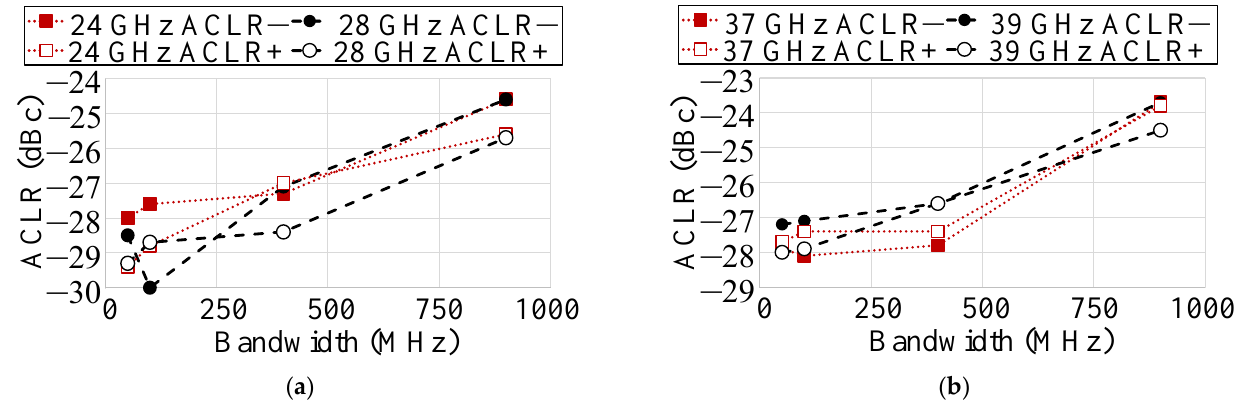
Figure 16. Measured ACLR+/ACLR- vs. carrier BW of the broadband CMOS FD-SOI PA at ( a ) 24 GHz and 28 GHz and ( b ) 37 GHz and 39 GHz.